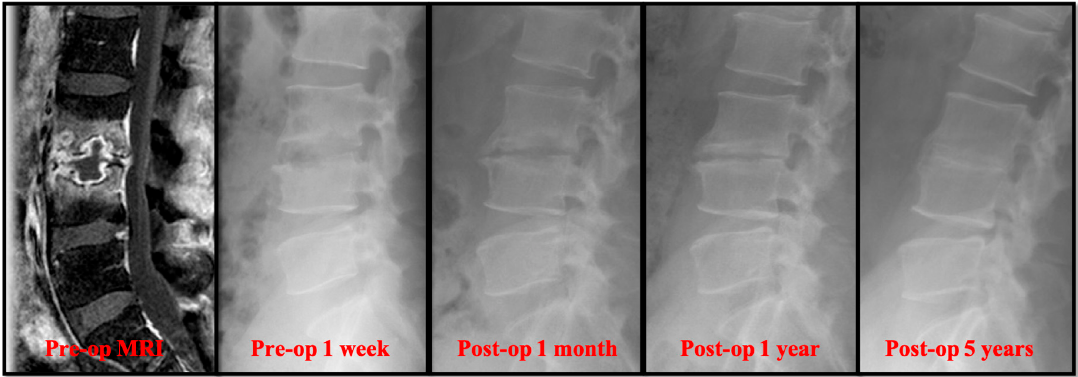
Figure 2. A 36-year-old man presented with severe pain in the lower back and leg. He was diagnosed with L3–L4 methicillin-resistant Staphylococcus aureus infection. The destructive endplate of the infected L3–L4 segment became sclerotic change although decreased intervertebral disc height and local kyphosis were observed after successful treatment in the PEDD group.